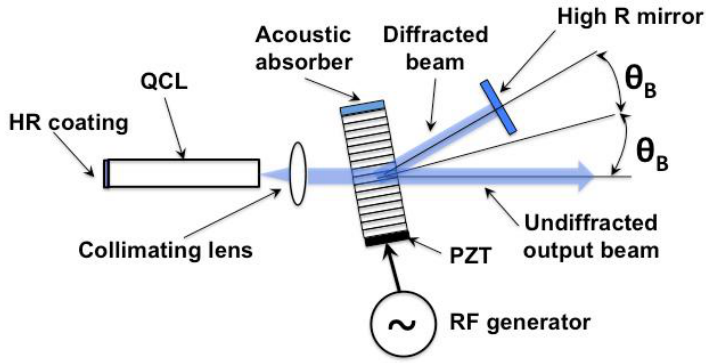
Figure 11. Configuration for extracting higher power output form the AOM-tuned QCL.